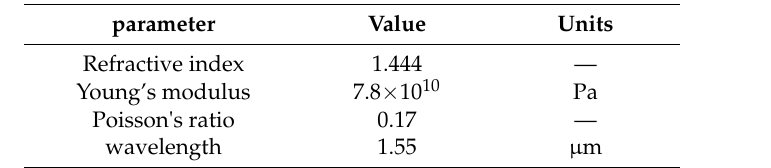
Table 1. Main parameter settings in the simulation.